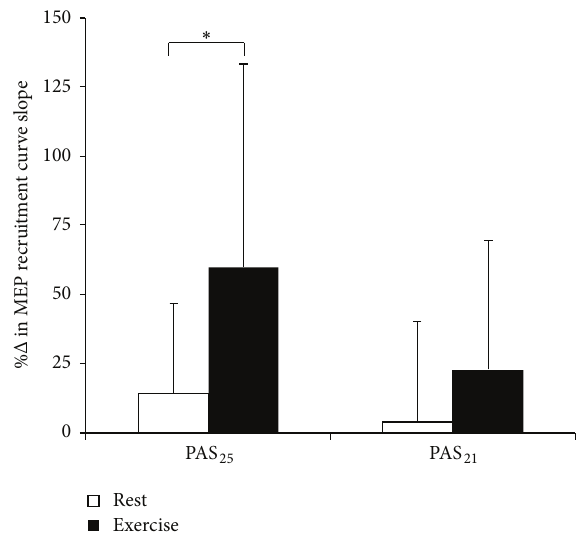
Figure 5: Change in MEP recruitment curve slope evoked by PAS under rest and aerobic exercise conditions. Asterisks indicate statistical significance ( 𝑝 < 0.05 ). Error bars represent one standard deviation. MEP: motor evoked potential; PAS 25 : paired associative stimulation with 25ms interstimulus interval; PAS 21 : paired associa- tive stimulation with 21 ms interstimulus